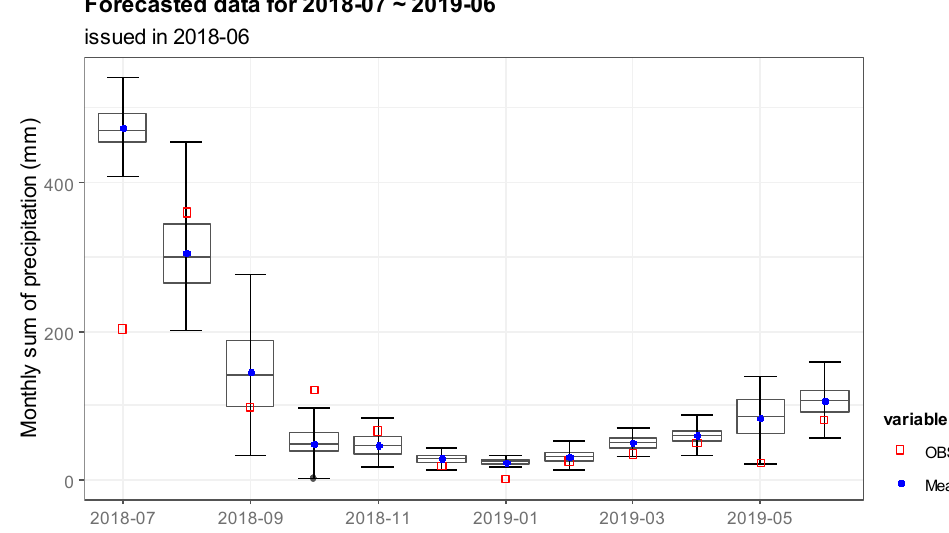
Figure 12. Results of monthly precipitation forecasting from July 2018 to June 2019.